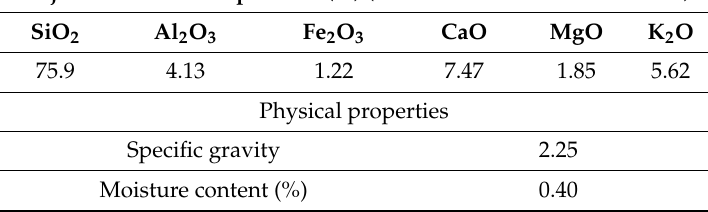
Table 6. Typical chemical and physical properties of bamboo leaf ash [63].